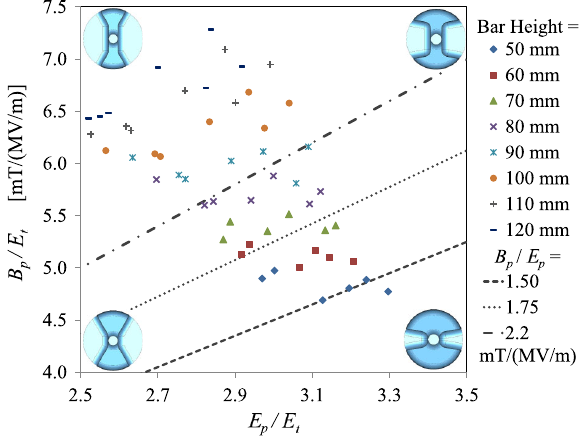
FIG. 23. Design parameters of optimization for the rf-dipole design with trapezoidal-shaped bars.